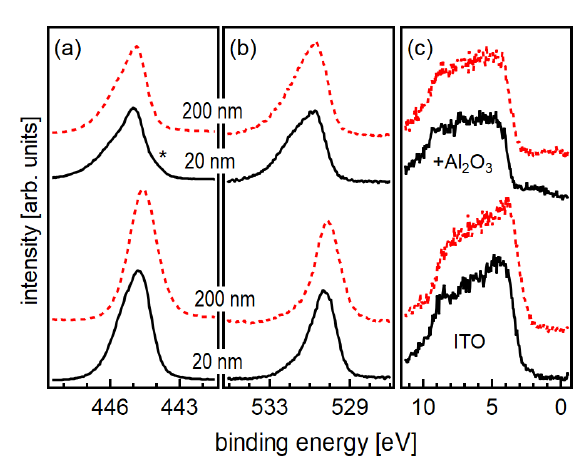
Figure 7. In3d ( a ), O1s ( b ) and valence band ( c ) X-ray photoelectron spectra of 20 nm (solid black lines) and 200nm (dashed red lines) thick ITO films before (bottom) and after (top) deposition of Al 2 O 3 using 5 ALD cycles. The asterisk indicates a shoulder in the In3d spectrum, which corresponds to a partial reduction of